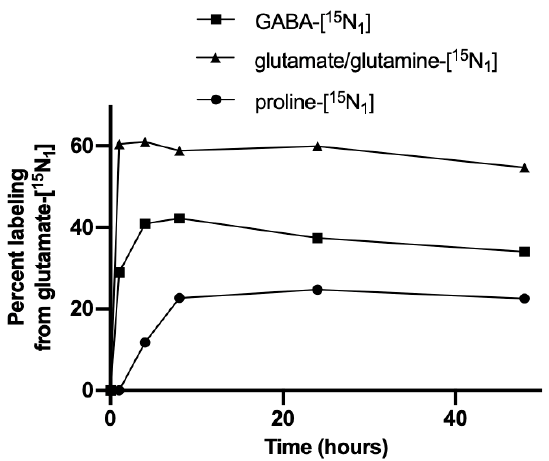
Figure 2. Time course of percent labeling of glutamate/glutamine-[ 15 N 1 ], GABA-[ 15 N 1 ], and proline-[ 15 N 1 ], from 10 mM glutamate-[ 15 N 1 ] applied to the foliage of creeping bentgrass (